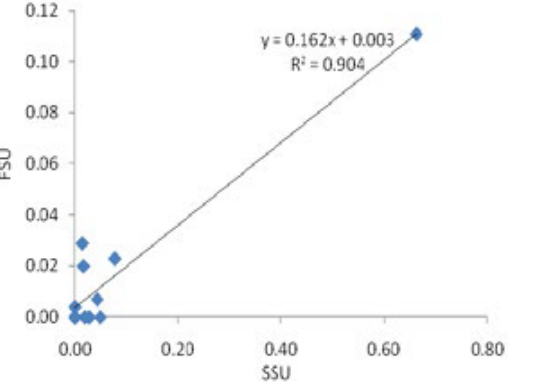
Fig. 4: Correlation between OC levels in FS M and SS and SS M M